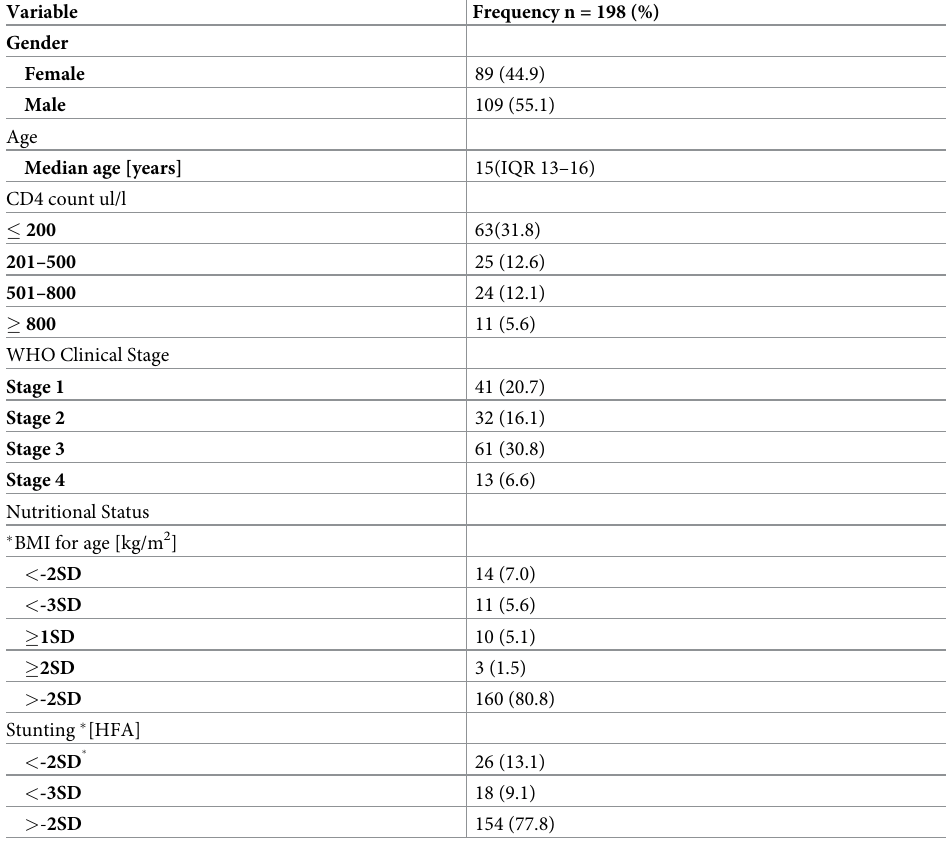
Table 1. Demographic and clinical characteristics of HIV infected children, on TDF for at least 6 months, < 18 years old, (n = 198).